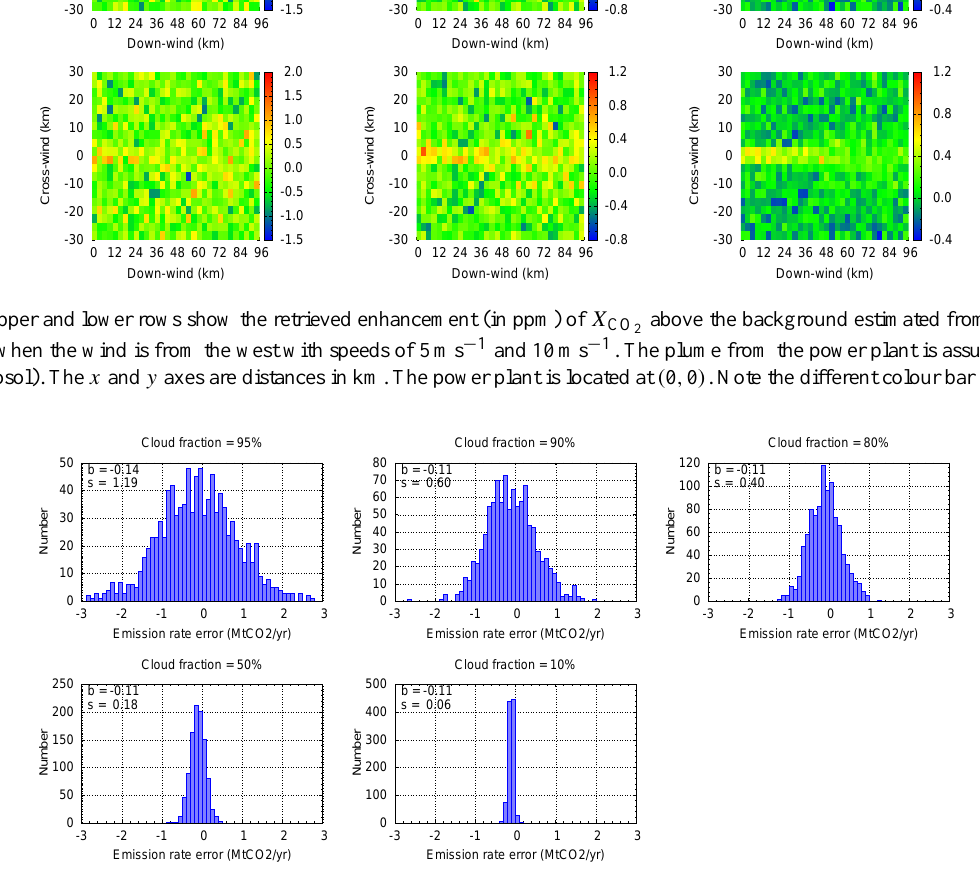
Fig. 21. Histograms of the error in retrieved emission rate (in MtCO 2 yr − 1 ) from 1001 simulations in which pixels are masked from the snapshots of the power plant and its surroundings. The masking is intended to simulate situations with partial cloud cover. The panels correspond to situations with 95%, 90%, 80%, 50% and 10% cloud cover.